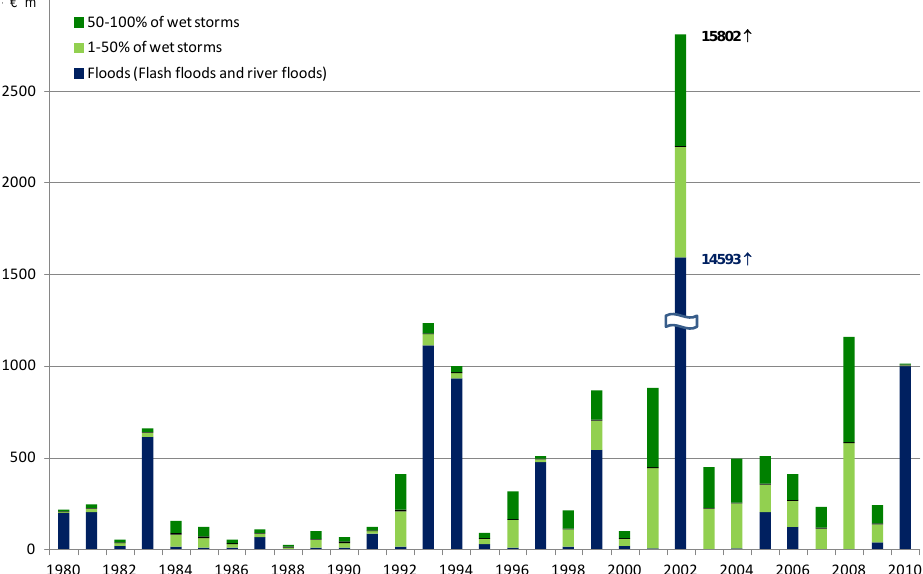
Fig. 7. Losses from floods and wet convective events (50+50%) 1980–2010 in Germany (in 2010 values). Note: The height of the bar for 2002 is not consistent with the axis.